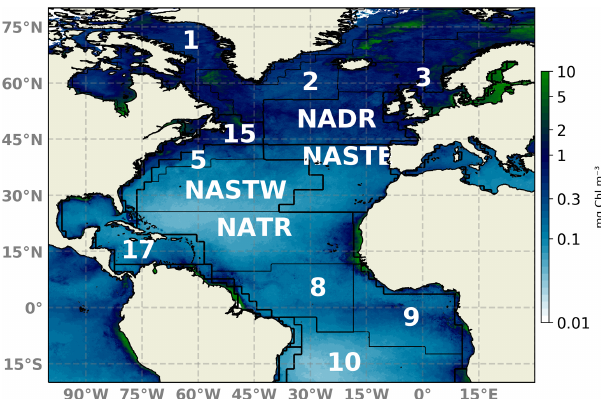
Figure 1. Schematic map of the North Atlantic basin showing the NATL-025/PISCES domain. Longhurst et al. (1995) biogeochem- ical provinces are indicated. Provinces are indicated by abbrevia- tions: NADR (North Atlantic Drift), NATR (North Atlantic tropical gyre), NASTE (northeast Atlantic subtropical gyre), and NASTW (northwest Atlantic subtropical gyre) are used throughout the text. A 2018 yearly composite of sea surface Chl a is